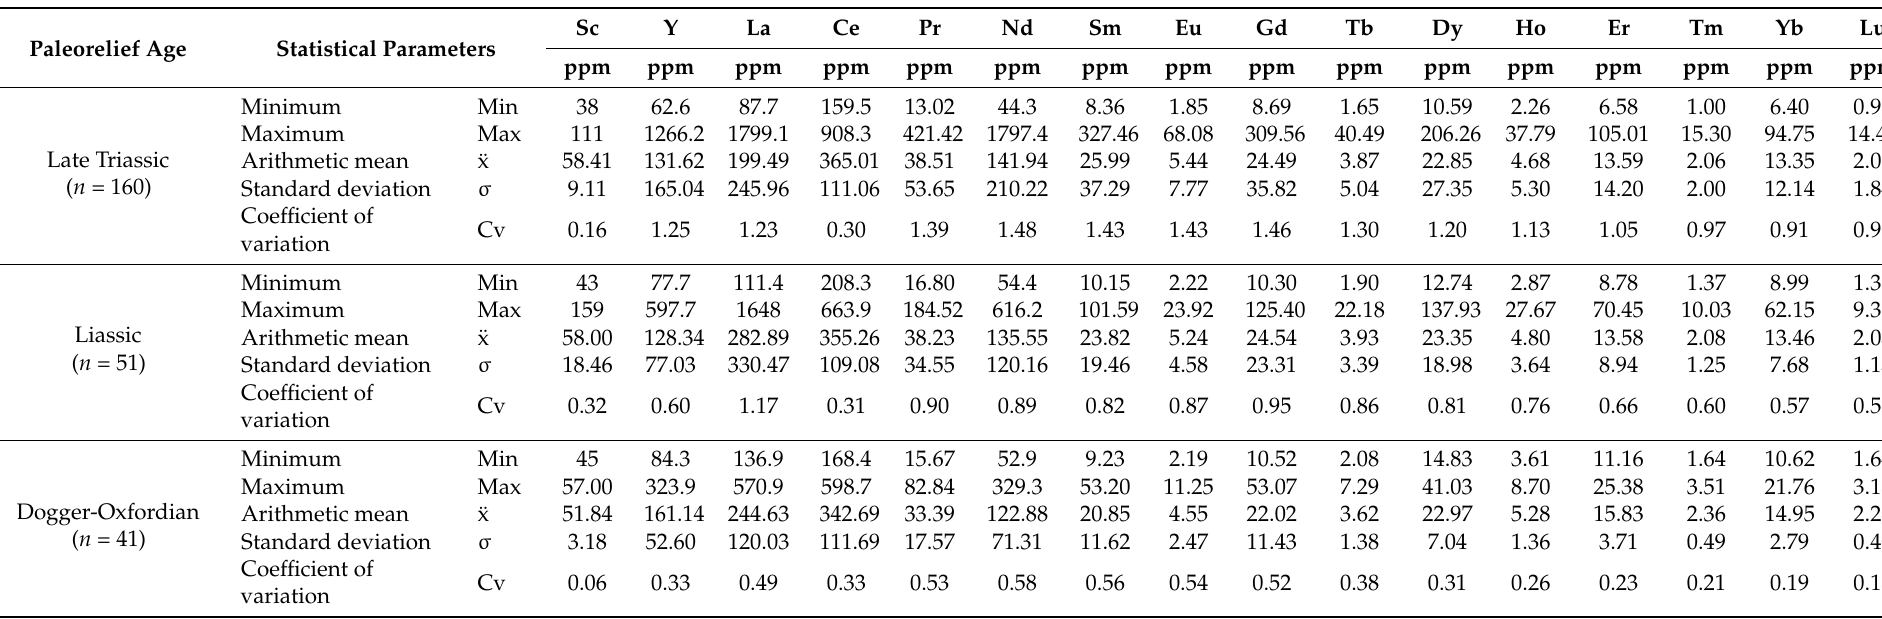
Table 11. Statistical parameters of geochemical analyses of rare earth elements, Y and Sc in Jurassic bauxites of the Vojnik-Maganik and Prekornica ore regions (after Radusinovi´c [5]). Paleorelief